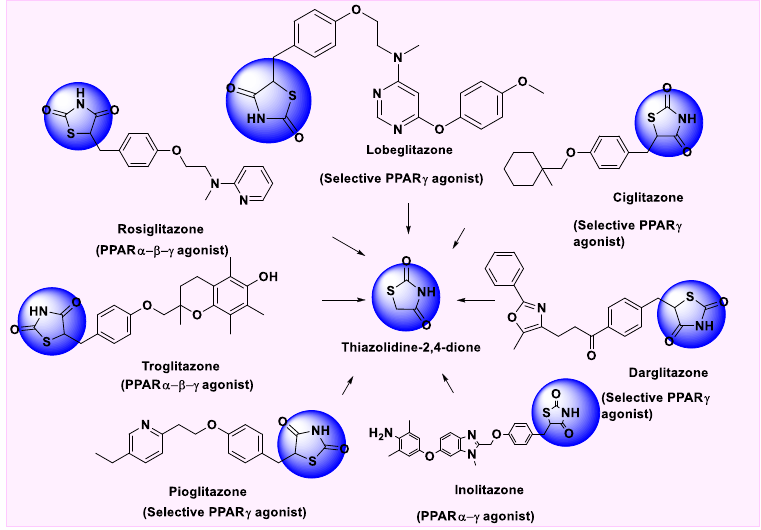
Figure 5. TZD scaffold containing PPAR ligands present in the market. Darwish et al. designed and synthesized some thiazolidinedione derivatives with the